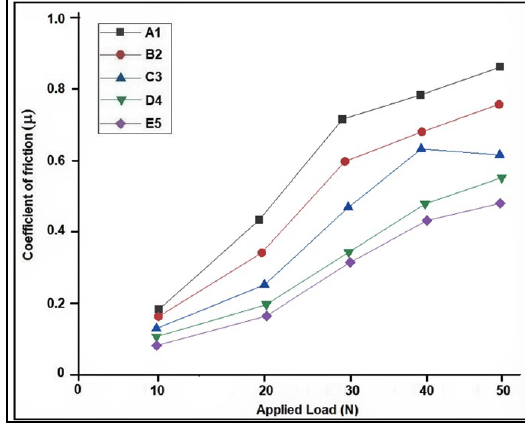
Figure 3. Friction force at 10N Load and 3 m/s sliding velocity.